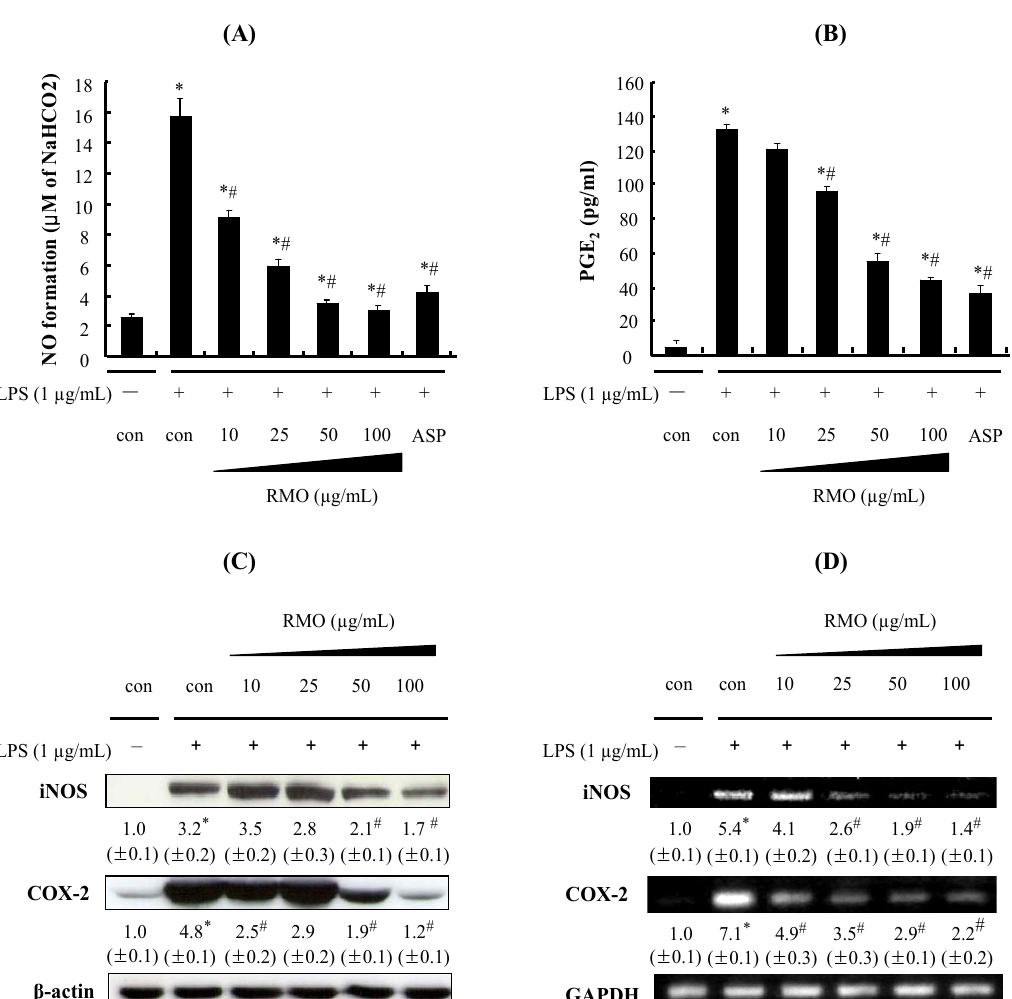
Figure 2. RMO inhibits LPS-induced NO and PGE productions and iNOS and COX-2 2 expressions in RAW 264.7 cells. Cells were pretreated with RMO (10, 25, 50 and 100 μ g/mL) for 1 h and then exposed to 1 μ g/mL of LPS for 24 h. ( A ) The culture medium was subsequently collected, and the nitrite concentration was measured by the Griess reaction. ( B ) Each culture supernatant was subsequently collected, and the amount of PGE 2 released was measured using the PGE Parameter Assay Kit. Data are presented as the 2 means ± S.D. of three independent experiments. *, # Significantly different from the no treatment and LPS-treated control, respectively ( p < 0.05). Aspirin (ASP) was used as a positive control. ( C ) Treatment of RAW 264.7 cells with RMO for 1 h followed by stimulation with LPS (1 μ g/mL) for 24 h in the continued presence of RMO. Then the cells were harvested and whole cell extracts were prepared for Western blot analysis for the indicated proteins. ( D ) The cells were treated with RMO for 1 h, then stimulate with LPS for 24 h, mRNA of iNOS and COX-2 were measured by RT-PCR. The results are expressed as the means ± S.D. for three separate experiments, each with three